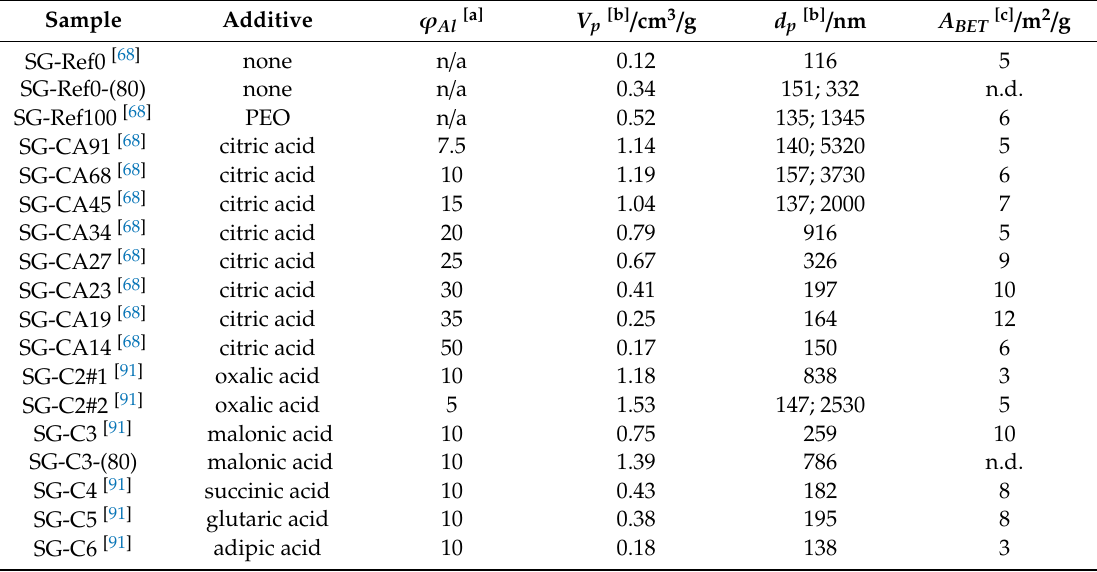
Table 4. Pore diameters and volumes for di ff erent amounts of selected additives in the sol-gel synthesis of macroporous α -Al 2 O 3 after calcination at 1200 ◦ C. Most data are adapted from [68] and [91]. Samples SG-Ref0-(80) and SG-C3-(80) are presented here for the first time. Sample